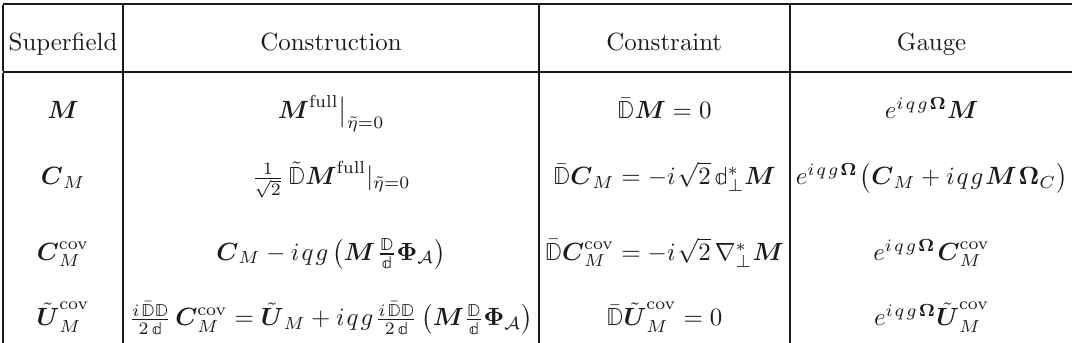
Table 7 . Collinear charged matter superfields, along with their top-down construction and gauge transformation properties. The RPI transformations are the same as the analogous ones in table